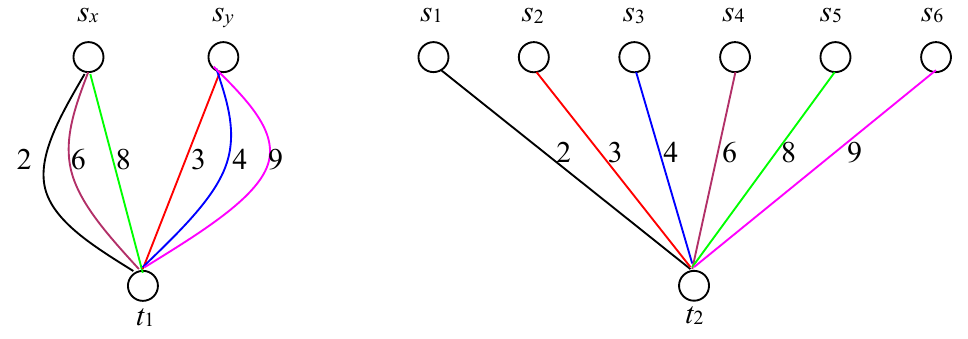
Figure 11. An edge coloring of G ’ generated from G.